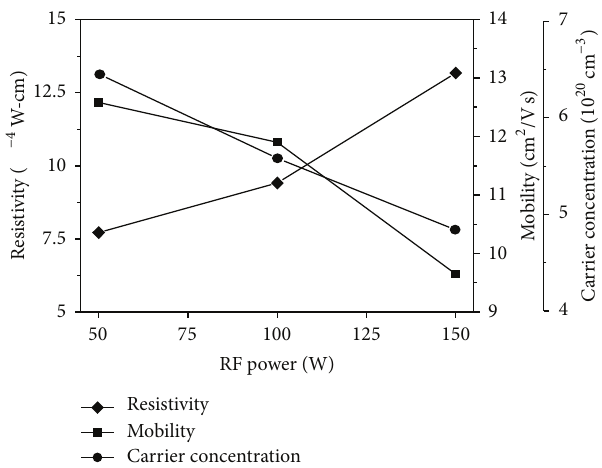
Figure 5: Resistivity ( 𝜌 ), Hall mobility ( 𝜇 ), and carrier concentra- tion ( n ) of the GZO thin films as a function of deposition